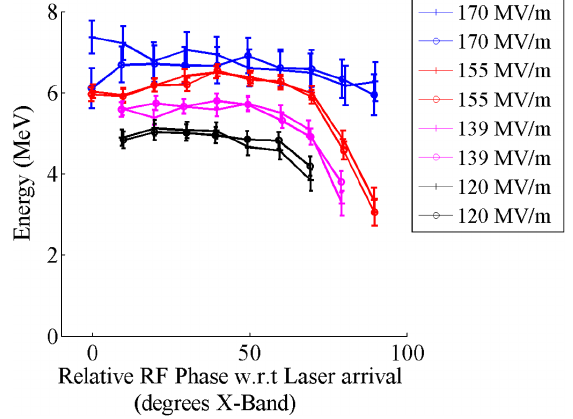
FIG. 14. Bunch energy versus rf-to-laser phase measured after the gun at different cathode gradients using either the horizontal (data points with crosses) or vertical corrector magnets (data points with circles). The gradient is based on the SLED-II power level with the expectation that 150 MW, corresponding to 15.3 MW at the gun input, yields a 190 MV = m cathode field (as discussed below).